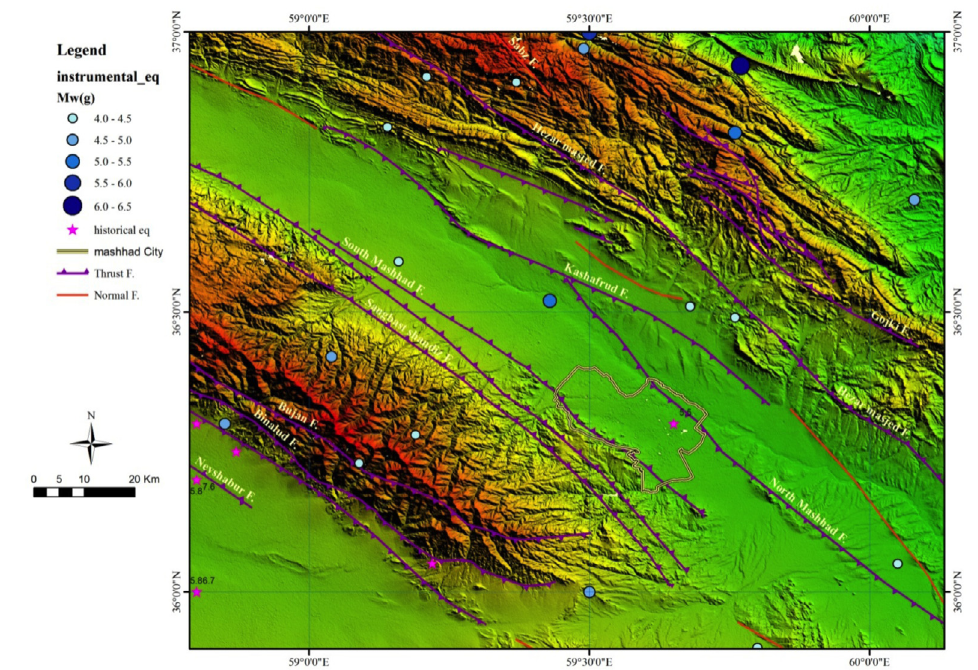
Figure 2. Seismotectonic map of Mashhad